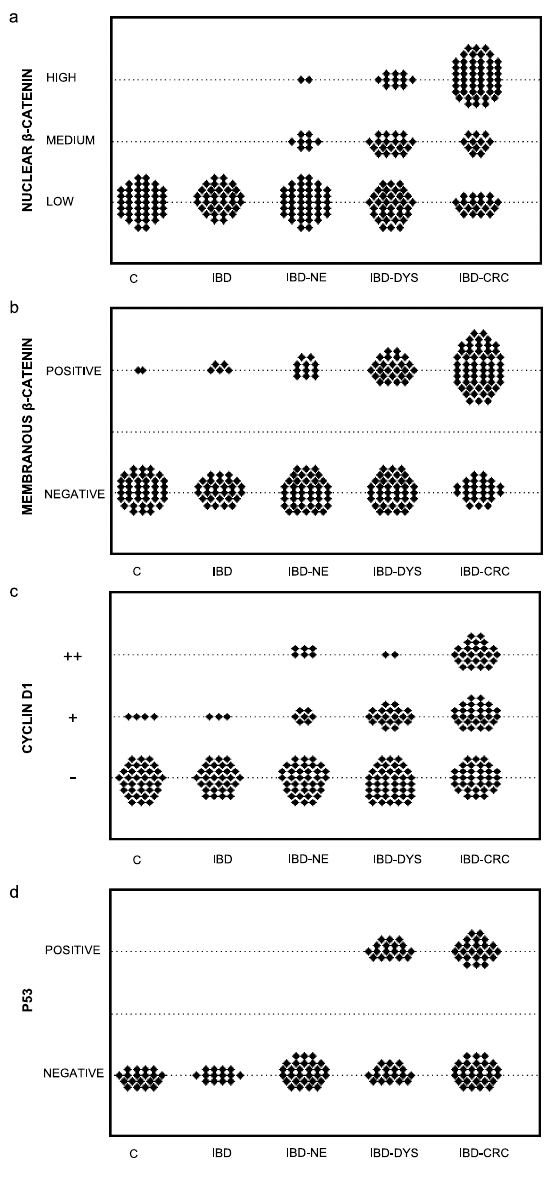
Fig. 1. Expression level per core. (a) Nuclear β -catenin expression: determined by percentage of positively stained nuclei grouped in low ( < 10%), medium (10–50%), and high ( > 50%). (b) Membra- nous β -catenin expression: grouped in positive (reduced of absent membranous staining, indicating an activated Wnt pathway) or neg- ative (presence of membranous staining, indicating an inactivated Wnt pathway). (c) Cyclin D1 expression: determined by the intensity of the expression grouped in negative ( − ), positive ( + ) or strongly positive ( ++ ). (d) p53 expression: grouped in a positive expression or negative (no or < 20% cells with expression of